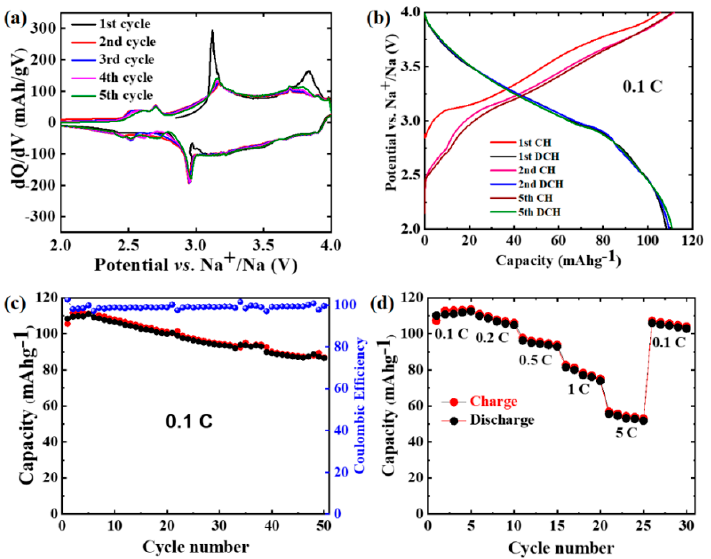
Figure 2. Electrochemical performance of NFCTO electrode, ( a ) dQ/dV plot for cycles 1–5 at 0.1C, ( b ) charge/discharge curves at 0.1C for the 1st, 2nd, and 5th cycles, ( c ) charge/discharge capacities at 0.1C between 2 and 4 V vs. Na + /Na, and ( d ) rate performance at various current